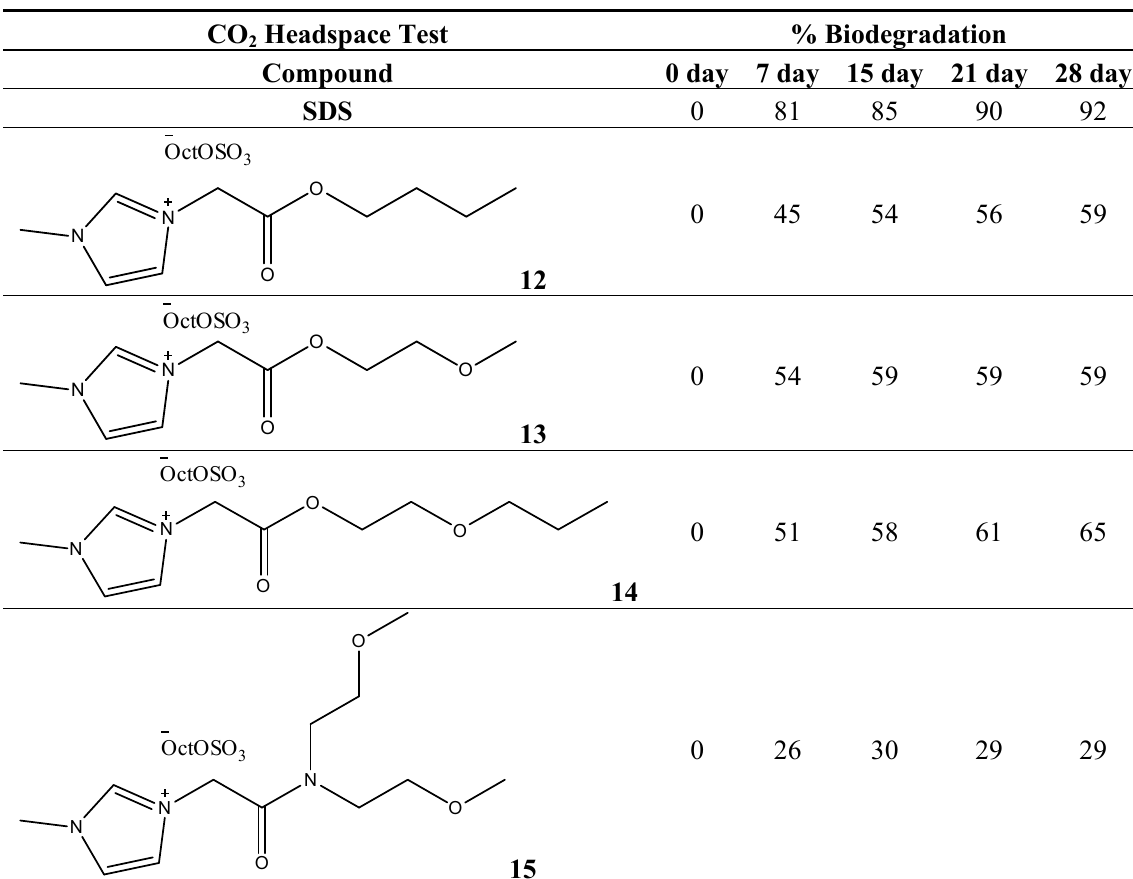
Table 3. Examples of some oxygen functionalized ILs with octyl sulphate anions (OctOSO 3− ) ( 12 – 14 ) and their biodegradation results. For comparison, an amide functionalized ILs ( 15 ) is included. Note: Poor biodegradability of first generation of amide ILs. SDS = Sodium dodecyl sulfate.